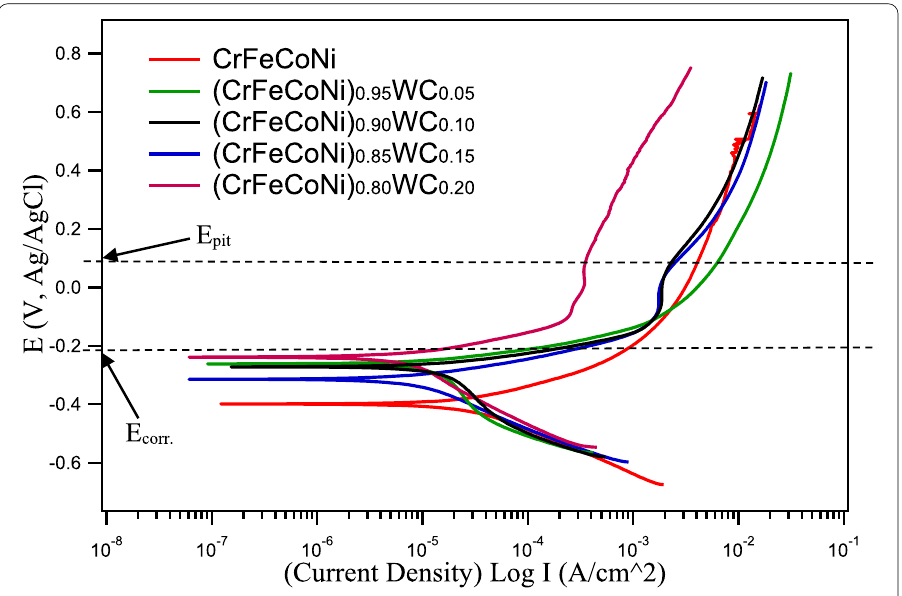
Fig. 9 Potentiodynamic polarization curves of the (CrFeCoNi) 1-x (WC) x HEA